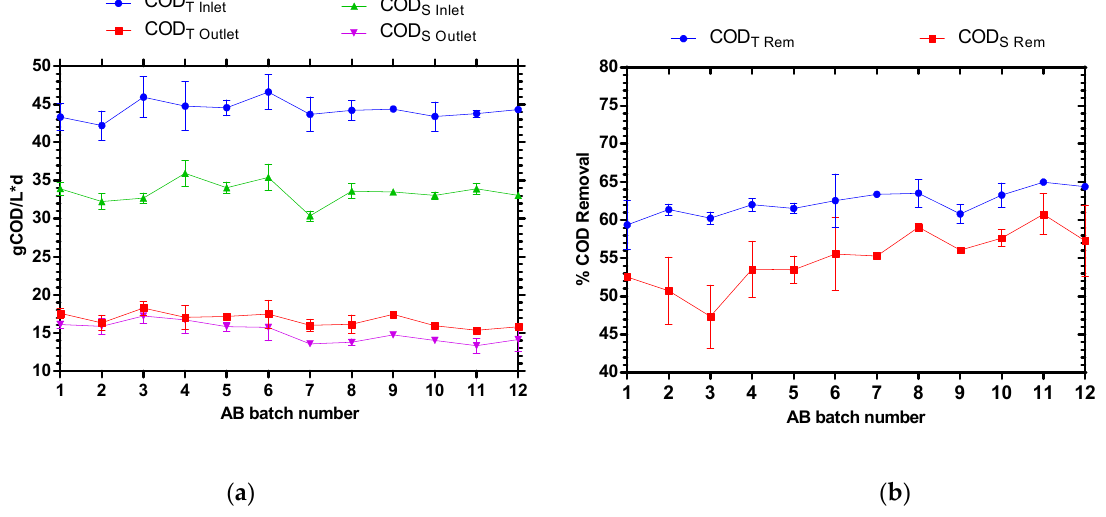
Figure 4. Testing of the AB: ( a ) inlet and outlet concentration; ( b ) percentage of COD removed. The TS and TVS contents in the effluent were about 7.19 and 4.4 g/L, respectively, in Stage 1. This indicates that about 68% of the TS and 86% of the vs. were removed in the AB.